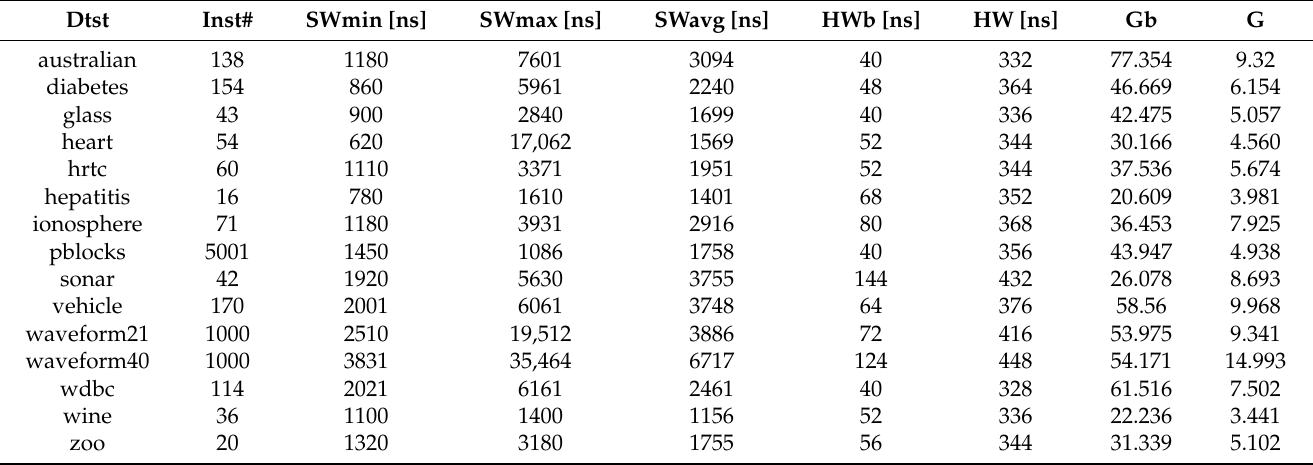
Table 11. Processing latency comparison between the software implementation of DT classifier compared to SRMLC.